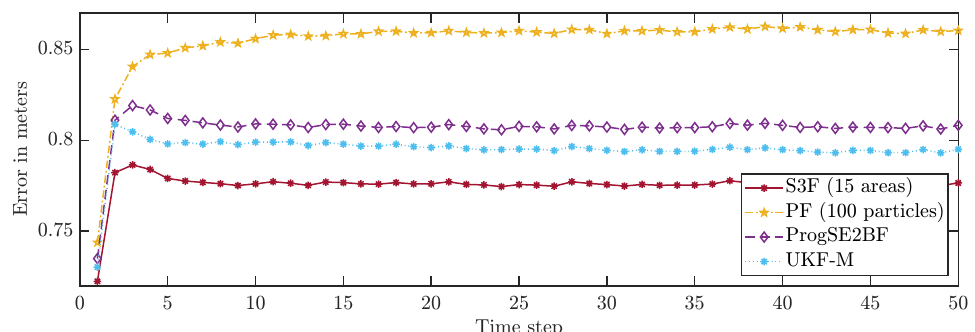
Figure 8. Average position errors in all time steps.